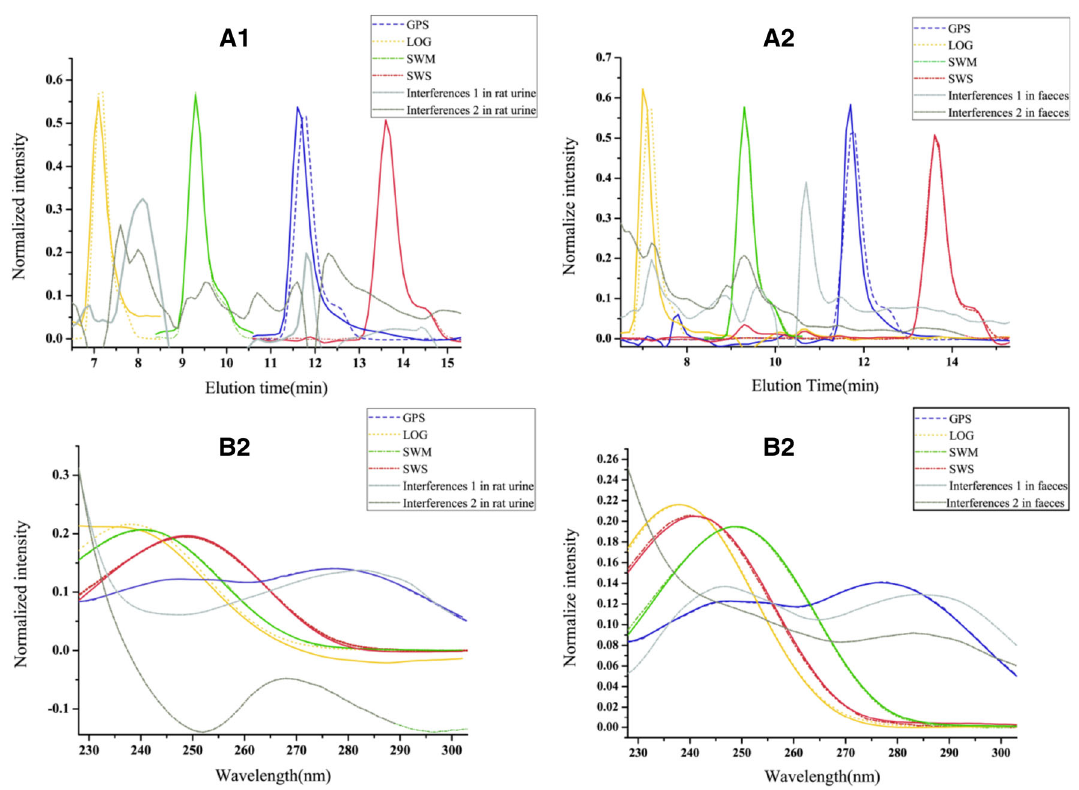
Fig. 3 Actual and resolved elution profiles ( a1 ) and wavelength profiles ( b1 ) of four bioactive ingredients in rat urine by using ATLD. Actual and resolved elution profiles ( a2 ) and wavelength profiles ( b2 ) of four bioactive ingredients in rat feces by using ATLD. Solid lines,